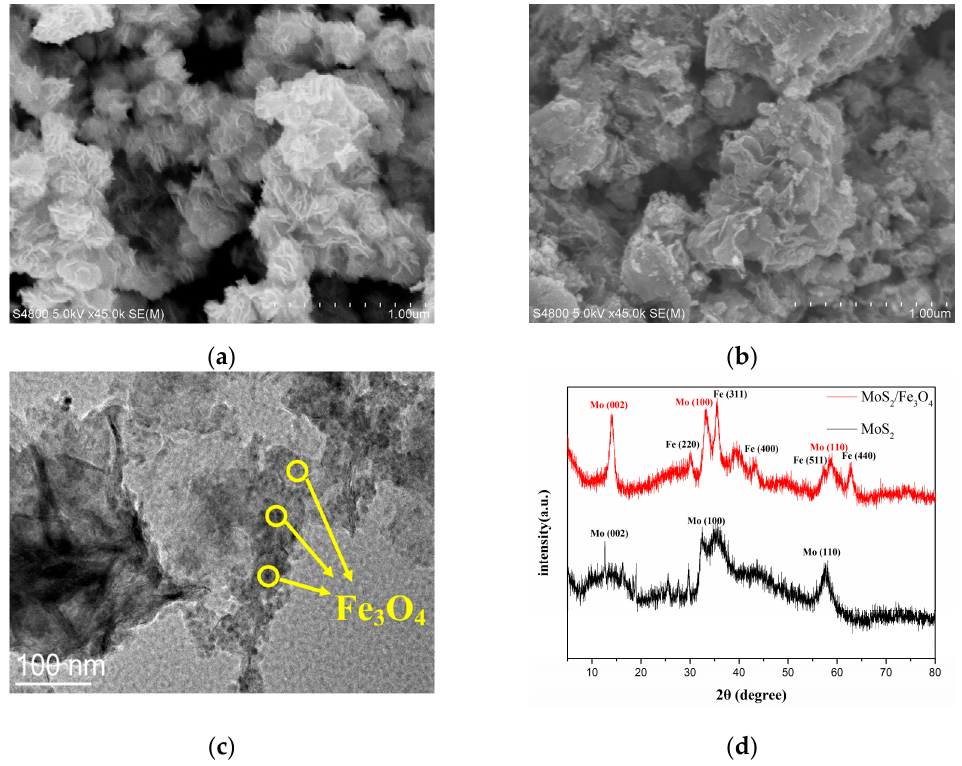
Figure 1. ( a ) SEM image of MoS 2 ; ( b ) SEM, ( c ) TEM, and ( d ) XRD images of MoS 2 /Fe 3 O 4 composites.